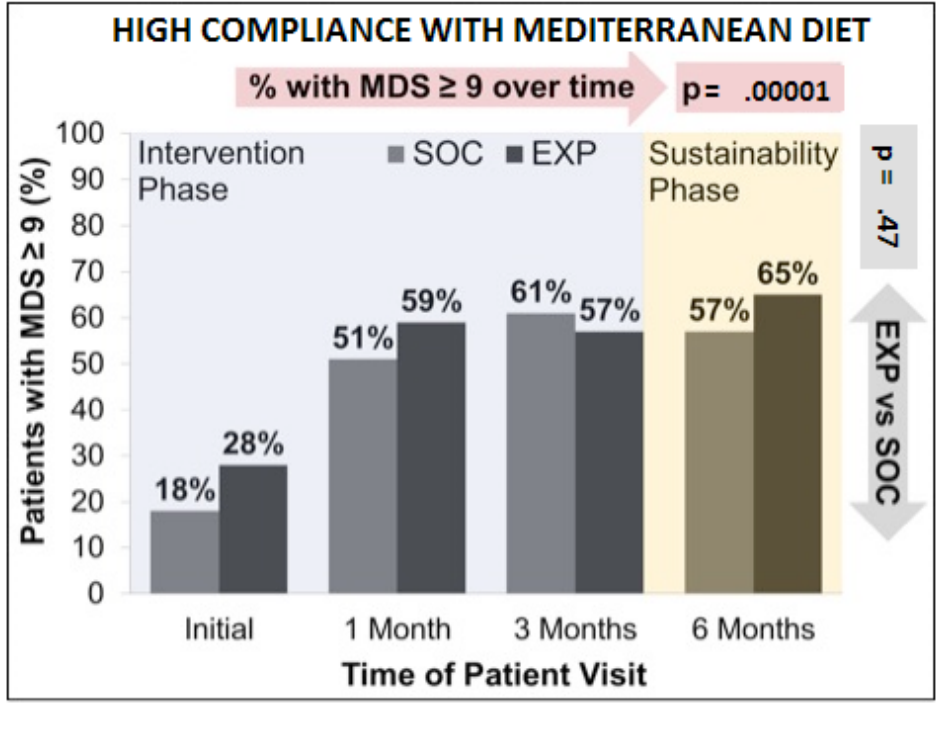
Figure 7. Proportion of patients achieving high compliance with the Mediterranean diet over time. MDS: Mediterranean diet score; SOC: standard-of-care arm; EXP: experimental